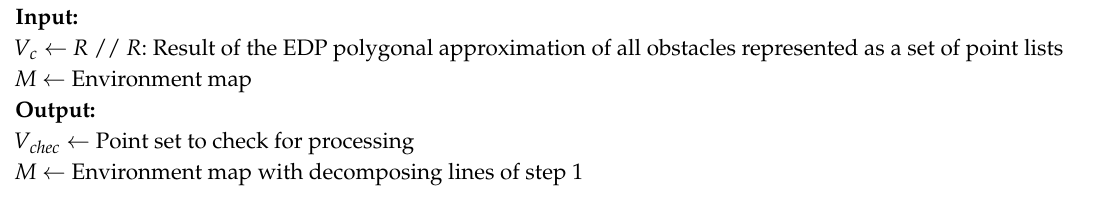
Algorithm 5. Pseudo Code of the modified OAECD (Step